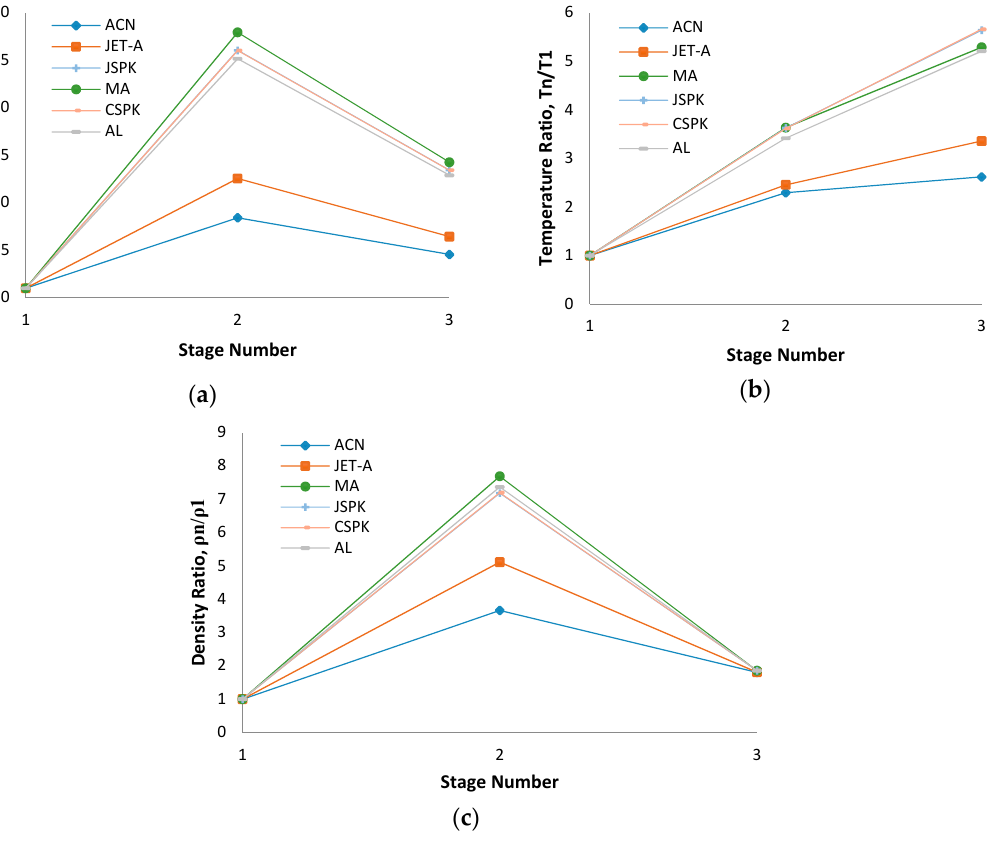
Figure 4. ( a ) Pressure ratios; ( b ) temperature ratios; and ( c ) density ratios at different stages.